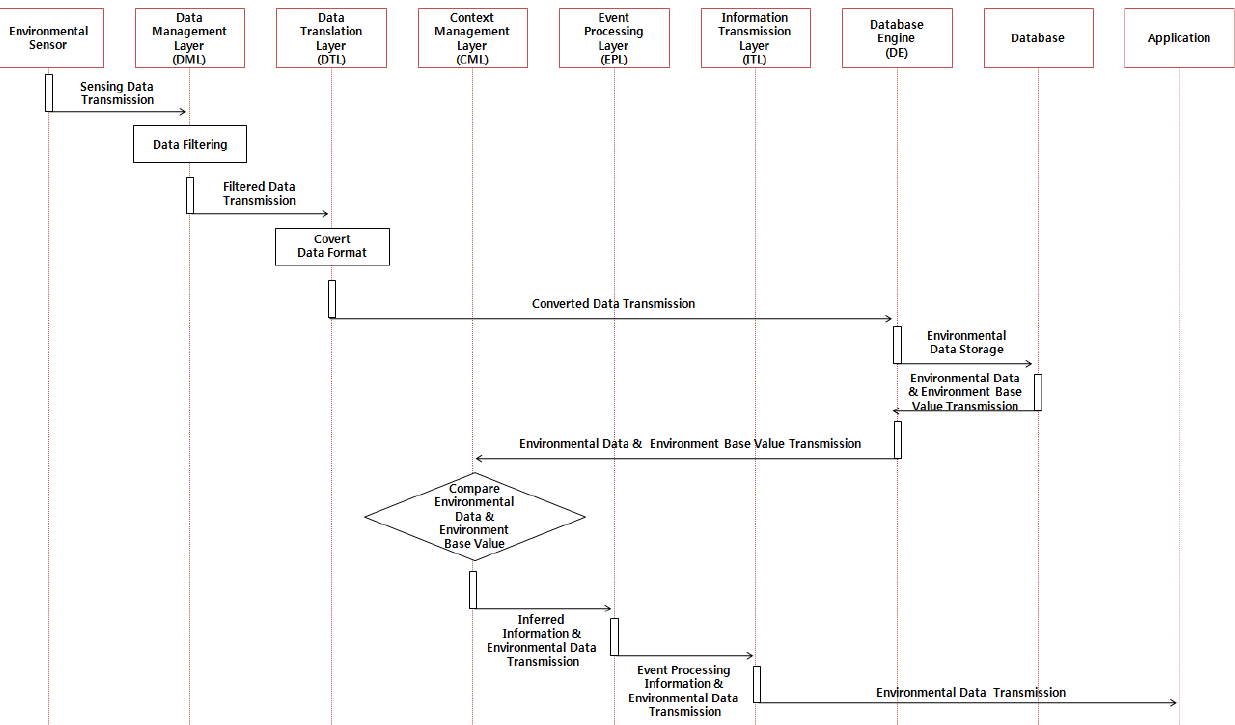
Figure 3. Operation of the Hog Farm Environment Monitoring Service.